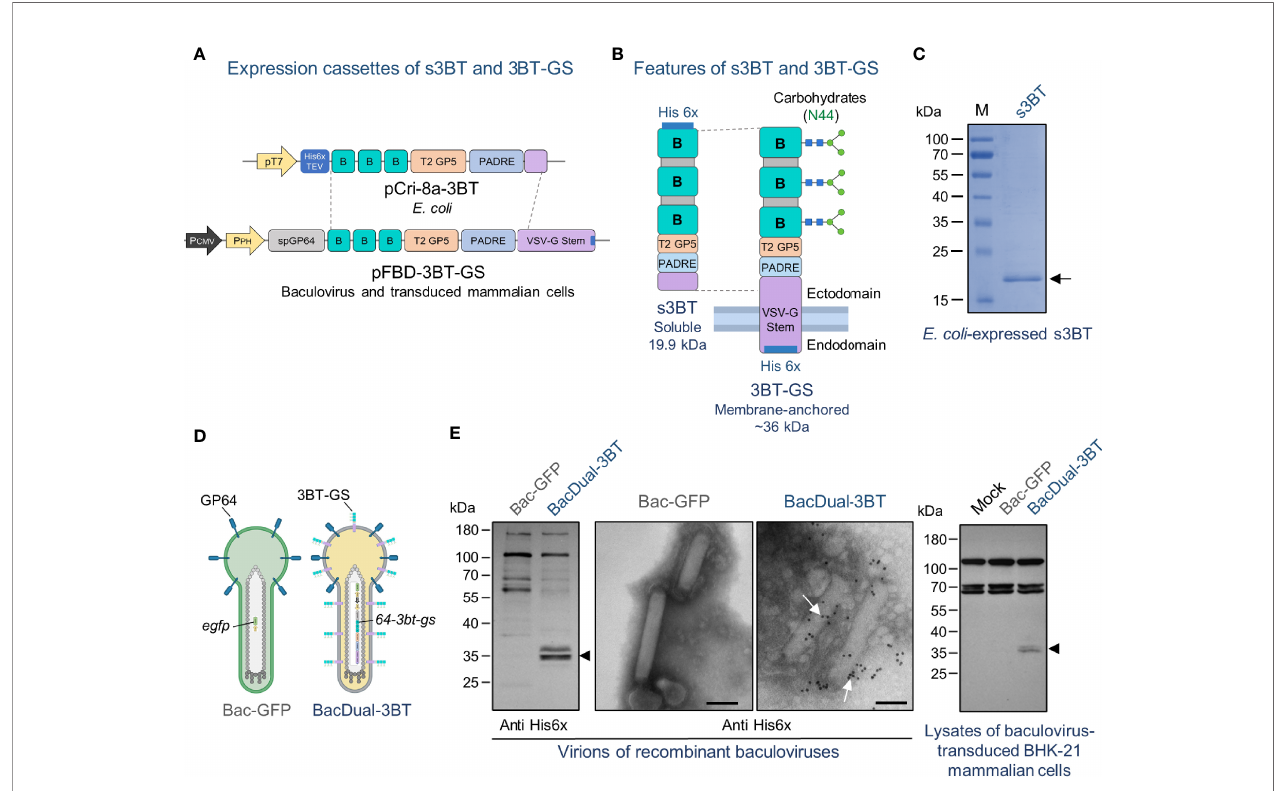
FIGURE 1 | The 3BT epitope-based antigen is expressed in the soluble form by E. coli , displayed on the membrane of the baculovirus BacDual-3BT, and produced in transduced mammalian cells. (A) Constructs were obtained to express s3BT in bacteria and 3BT-GS in baculovirus. In the vector pCri-8a, s3BT expression was driven by the T7 promoter. For expression of 3BT-GS on the baculoviral envelope and in mammalian cells, the polyhedrin promoter (PPH) and the cytomegalovirus promoter (PCMV) were cloned into pFastBac ™ Dual. TEV, Tobacco Etch Virus protease cleavage site; sp6P64, signal peptide of GP64. (B) A schematic of the two forms of 3BT epitope-based antigen that were evaluated in this study. GS, stem of VSV-G. (C) Coomassie-stained SDS- PAGE 10% gel, showing 10 µg of IMAC-puri fi ed s3BT protein expressed in E. coli . M, molecular weight marker. (D) Schematic representation of BacDual- 3BT expressing 3BT anchored to its membrane via GS. GP64 is the main membrane protein of the baculovirus AcMNPV, as shown in Bac-GFP. (E) Left: Immunoblotting of concentrated virions of BacDual-3BT to detect 3BT-GS protein with a polyclonal anti-His6x antibody (arrowhead). Center: Immunogold electron micrographs of concentrated virions of Bac-GFP and BacDual-3BT incubated with a polyclonal anti-His6x antibody and then with an anti-rabbit-gold conjugate. White arrows in the micrograph of BacDual-3BT indicate the presence of 3BT-GS protein on the surface of virions. Bars, 100 nm. Right: Immunoblotting of lysates of baculovirus-transduced BHK-21 cells (MOI = 200 PFU/cell) to detect 3BT-GS protein with a polyclonal anti-His6x antibody (arrowhead). Figure partially created with